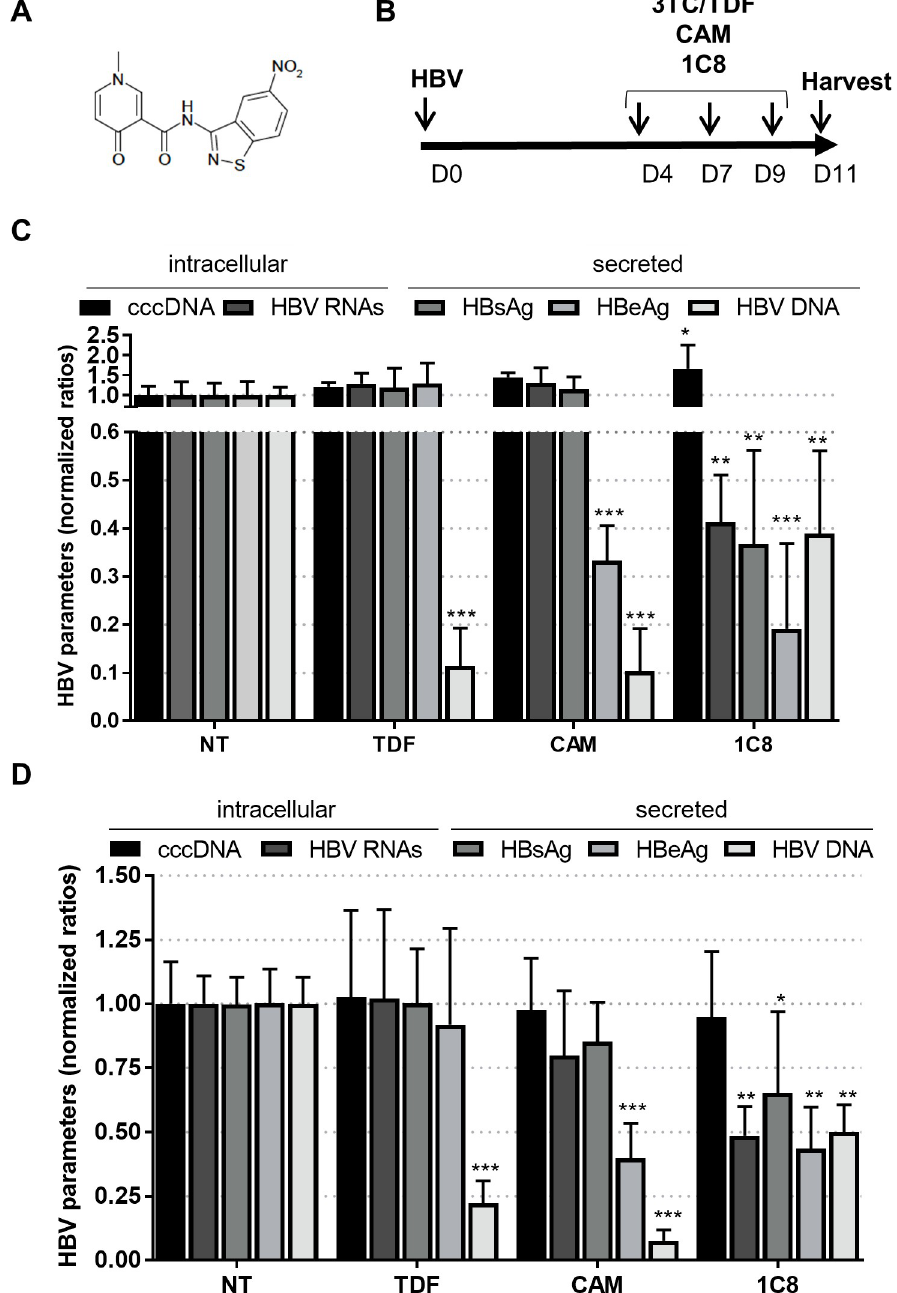
Fig 5. Effect of 1C8 on an established HBV infection. (A) Molecular structure of 1C8. (B) Outline of the experimental protocol: HBV-infected dHepaRG cells (C) or PHH (D) were treated three times with Tenofovir (TDF at 10 μ M), a Core allosteric modulator (CAM at 10 μ M) or 1C8 (10 μ M) starting at D4pi. Intracellular and secreted HBV parameters were quantified 2 days after the last treatment. Results are expressed as the mean normalized ratio +/- SD between non-treated and treated cells of 3 independent experiments, each performed in